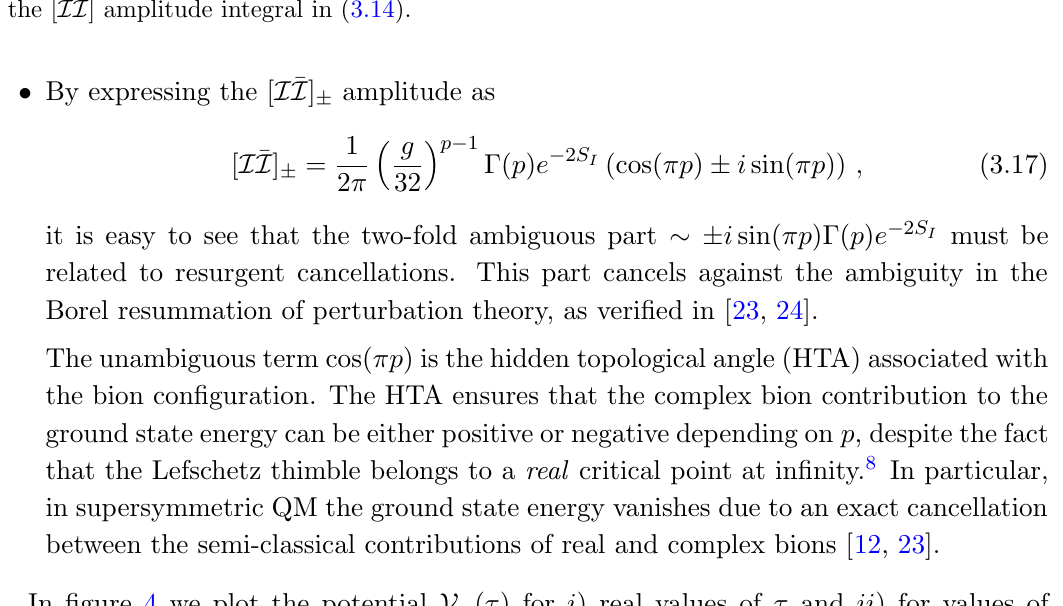
( (cid:28) ) associated with the [ I (cid:22) I ] con(cid:12)guration. For real (cid:0) (cid:16) (cid:17) A = ln + i(cid:25) gives the dominant contribution (cid:3) g p